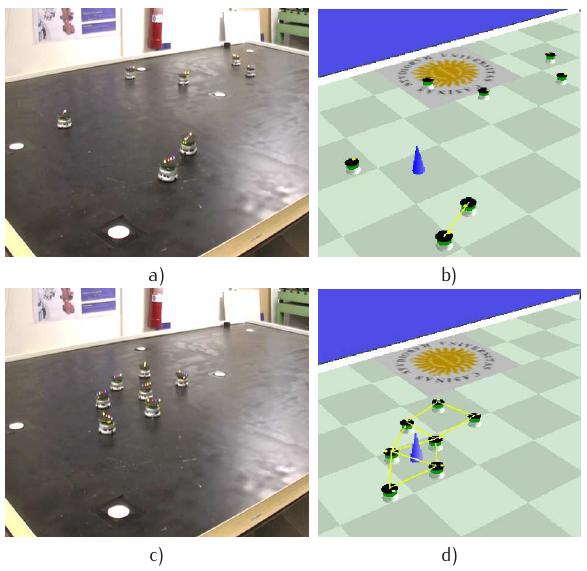
Figure 10. Snapshots of the initial and final configurations and their graphical elaborations of an experiment where seven robots flock around a fixed rendez vous point.